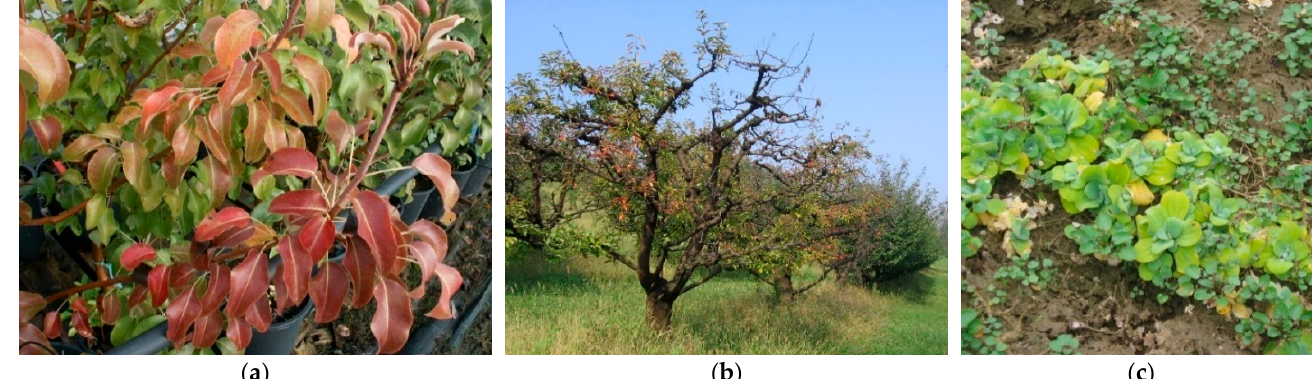
Figure 6. Reddening in pear decline ( a ), yellowing in plum ( b ) and watercress ( c ).